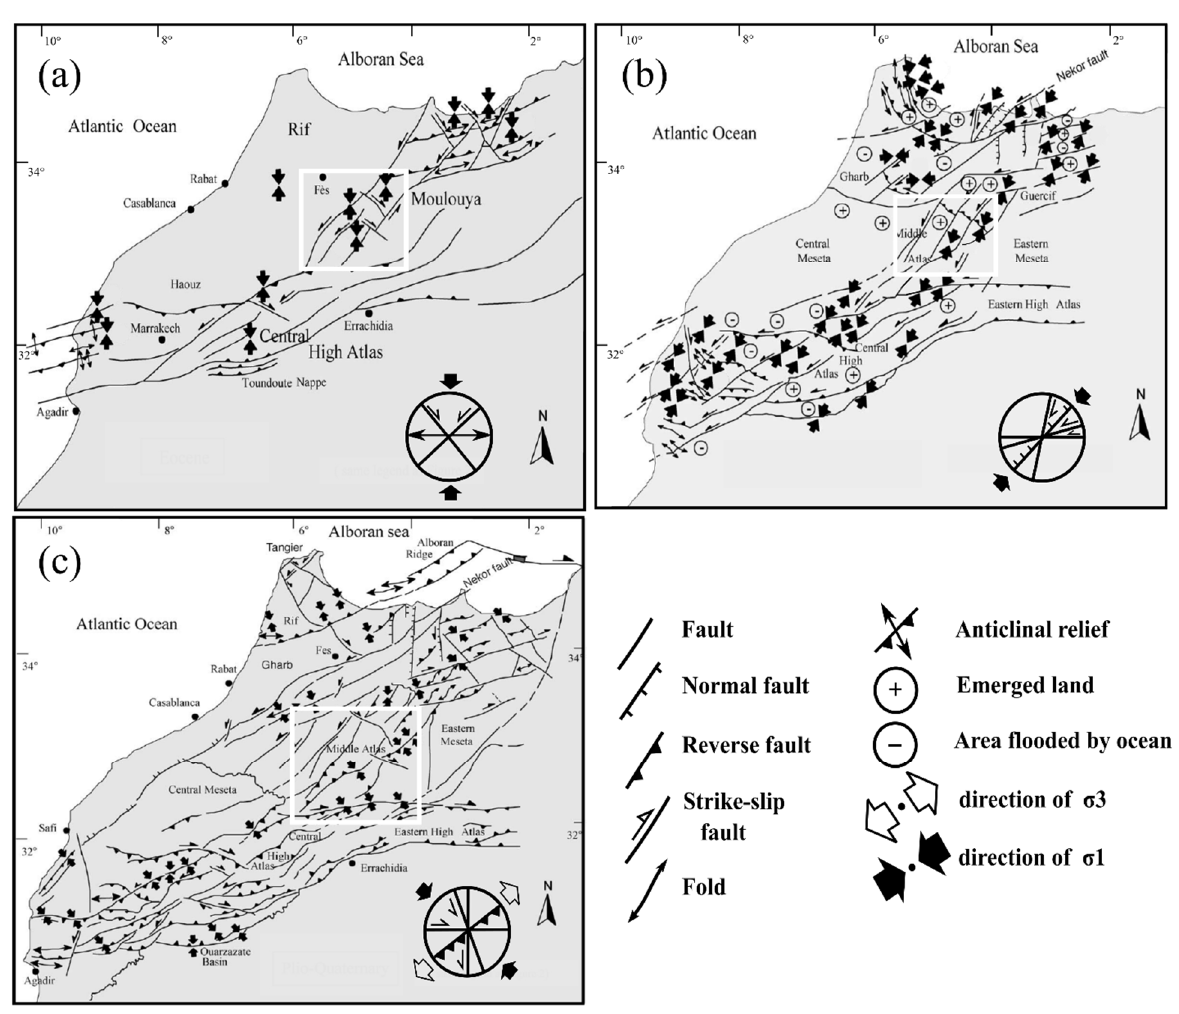
Figure 2. Structural map of Northern Morocco and paleostress directions: ( a ) Eocene; ( b ) Early– Middle Tortonian; ( c ) Plio-Quaternary, the white frame mean to the Middle Atlas area (after [65] ).